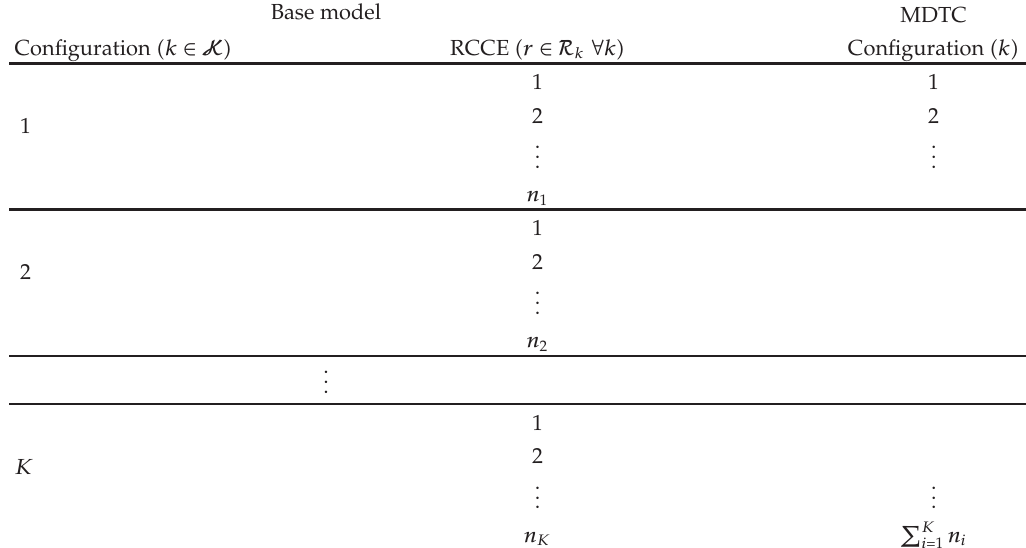
Table 2: Reindexing under MDTC model; each RCCE of the base model now represented as a unique configuration. Base model